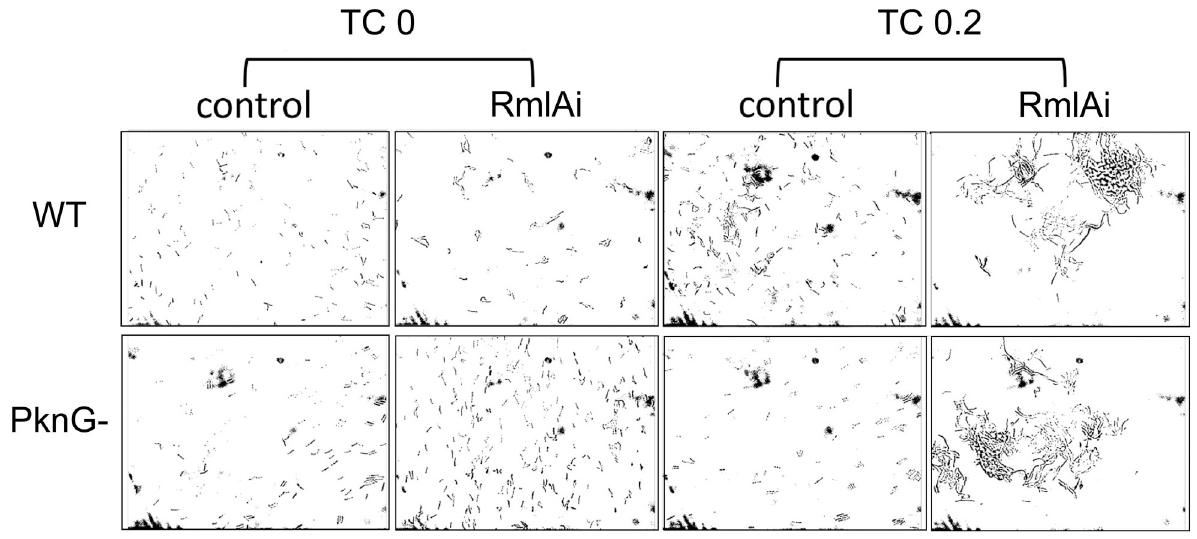
Fig 3. RmlAi cells are more prone to aggregation. The indicated strains were grown in liquid culture and streaked onto microscopy slides as described in Methods. RmlA overexpression was induced by the addition of 0.2 μ g/ml TC. The control strains do not carry the RmlAi plasmid.